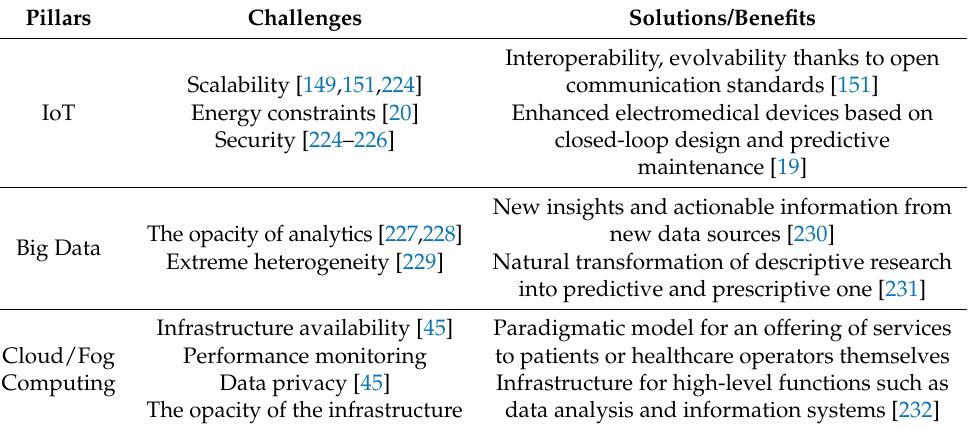
Table 5. Summary of IoHT applications based on IoT, ML, and BC.